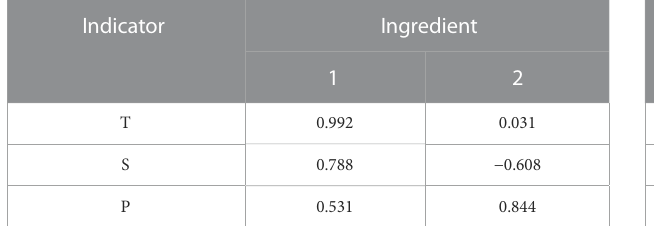
TABLE 4 Component matrix. TABLE 5 Component score coef fi cient